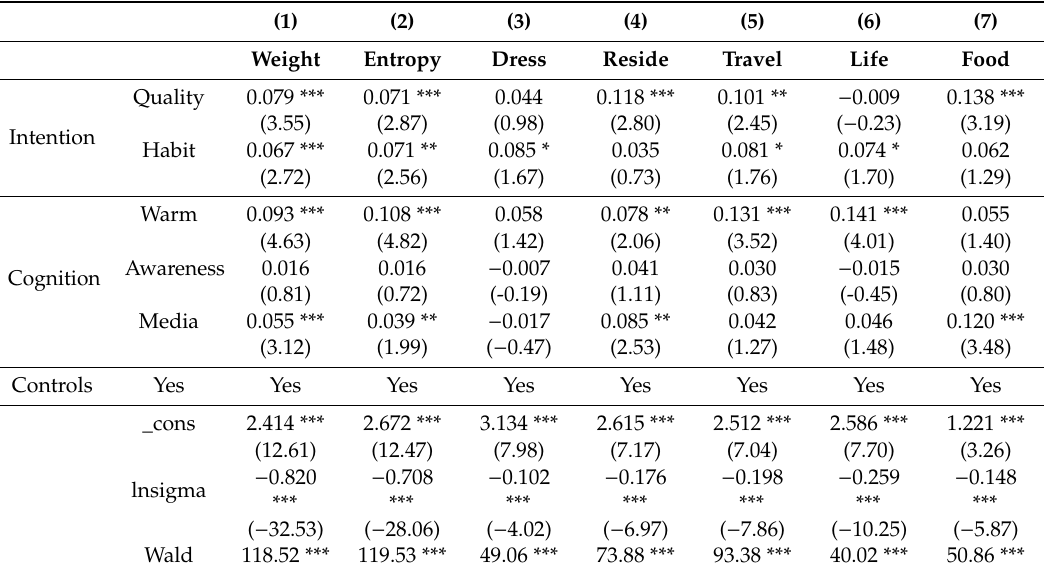
Table A2. Coe ffi cient under sample selection model.